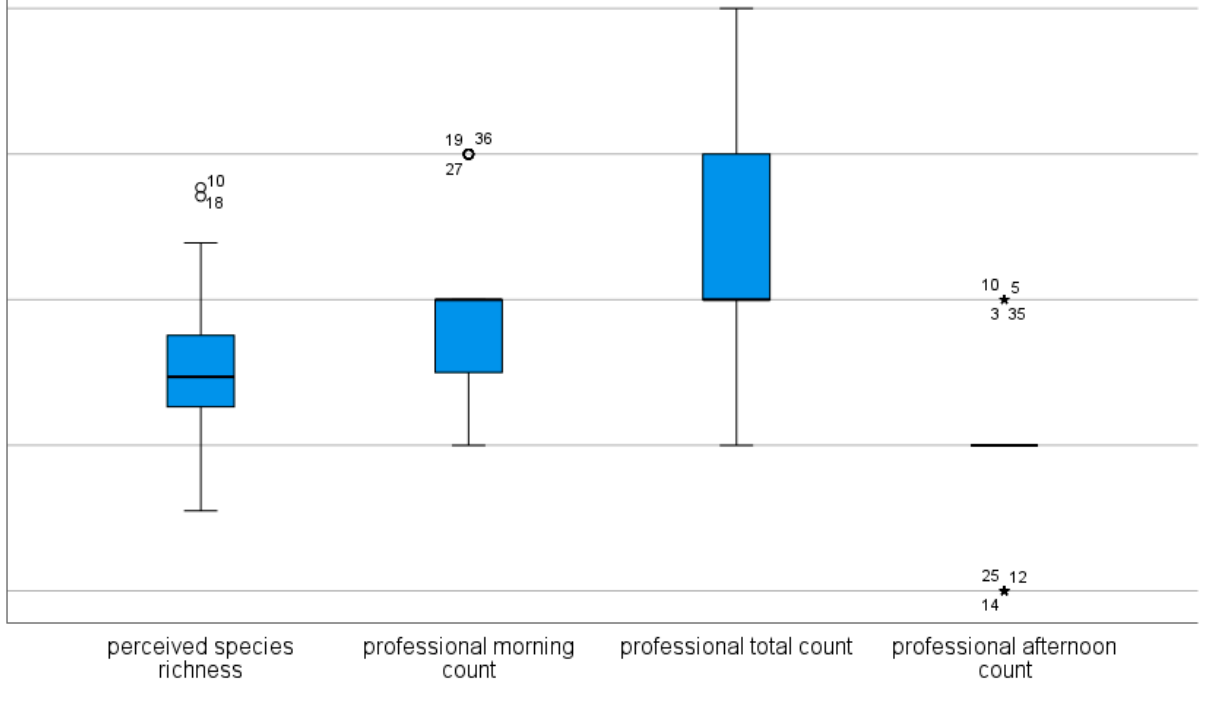
Figure 2. Boxplot of the results of the Wilcoxon test of the recoded variables into the same categories as the laypeople’s assessment: 1 = 0–5; 2 = 6–10; 3 = 11–20; 4 = 21–30; 5 = 31–40; 6 = 41–50; 7 = 51–60; 8 = 61–70; 9 = over 70. Professional total count: Z = − 5.028, p < 0.001 (negative ranks); professional morning count: Z = − 3.166; p = 0.002 (negative ranks); professional afternoon count: Z = − 4.382, p < 0.001 (positive ranks). The circles indicate outliers (numbers are respective case numbers), the * indicate extreme outliers. Numbers represent the